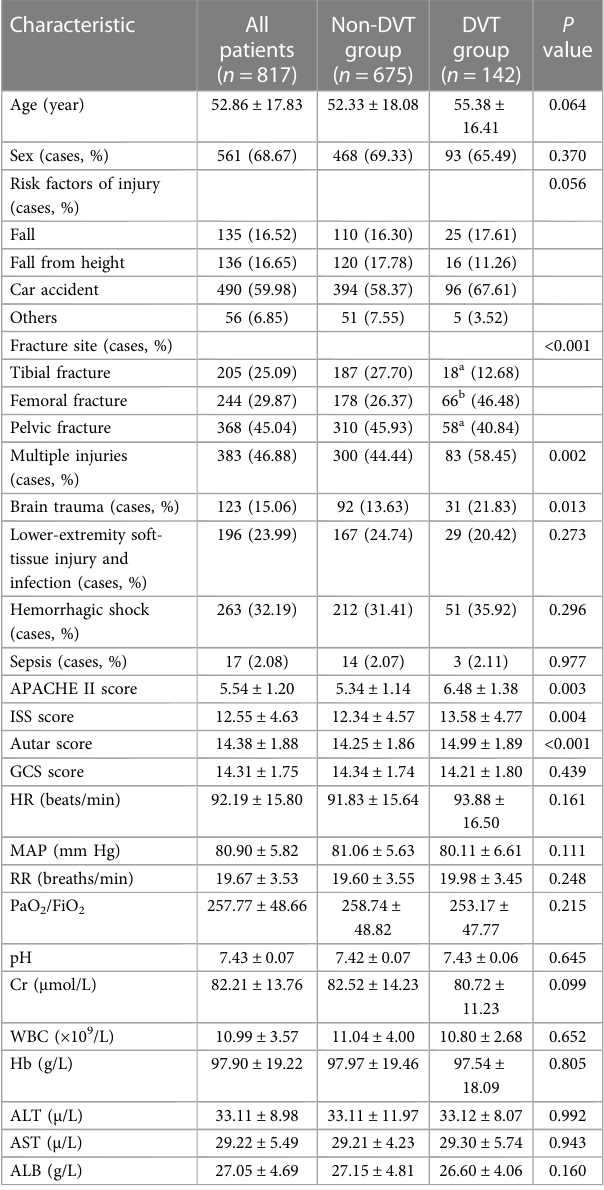
TABLE 1 Comparison of participant characteristics between the DVT and non-DVT groups.